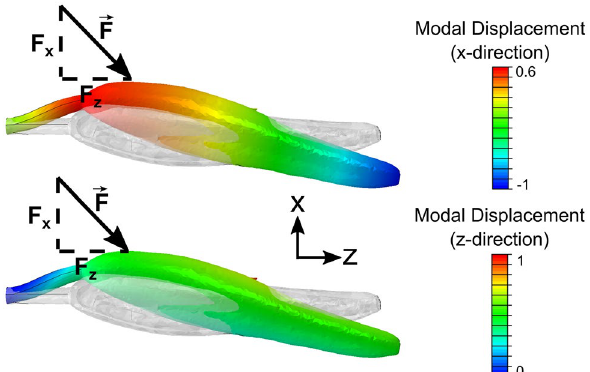
Figure 7. We hypothesize that bees excite this axial-bending mode during floral buzzing. The top and bottom figures show the modal displacement of the axial-bending mode in the x and z directions respectively. The force vector indicates the approximate direction and location a bee may apply forces to the anther. Note that modal displacements are arbitrary in units, and only indicate how points on a structure move in relation to one another if that mode is